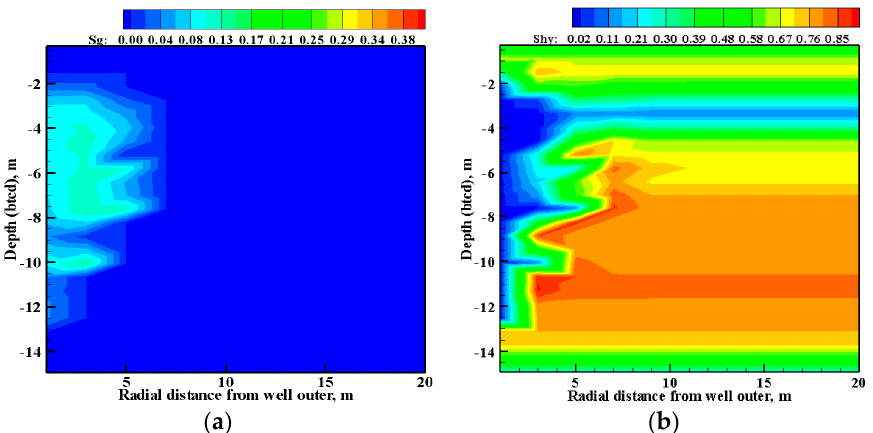
Figure 10. Saturation distributions at the end of production. ( a ) Gas phase saturation. ( b ) Saturation of the hydrate phase.